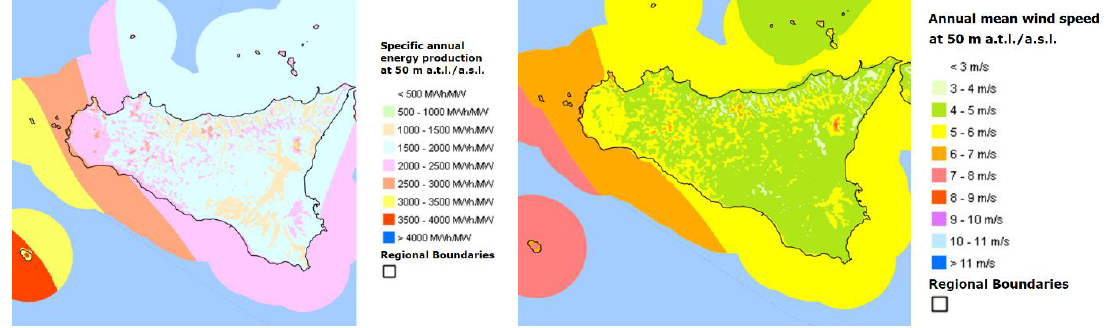
Figure 12. Wind Energy Evaluation along Pantelleria’ s coasts (energy power and average annual wind speed) [21].